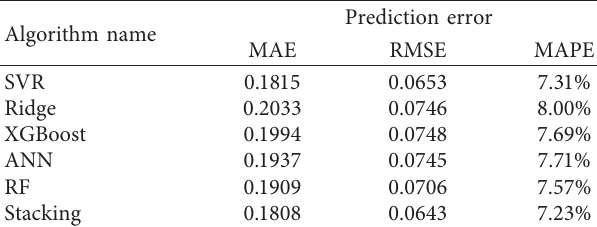
Table 5: Prediction error without considering time series